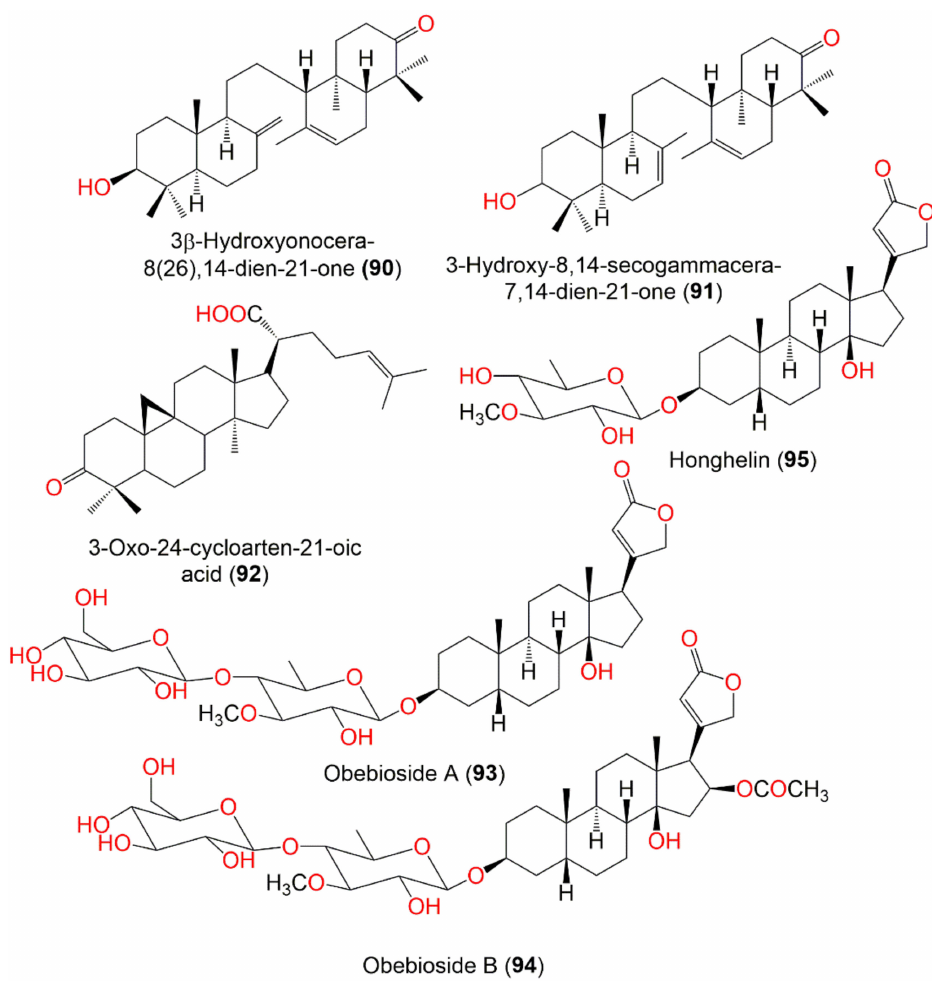
Figure 9. Structures of compounds 90 – 95 from Lansium domesticum